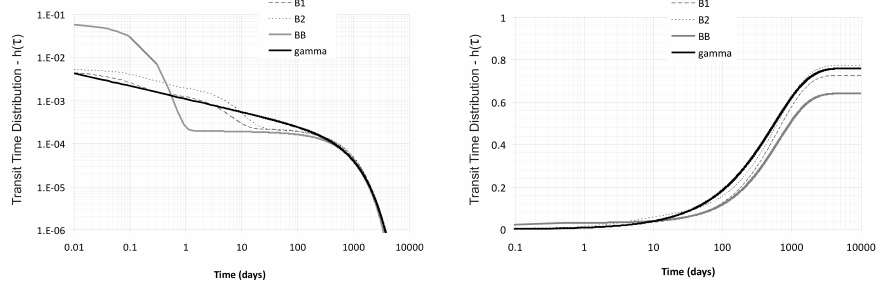
Fig. 7. Transit Time Distribution – TTD for the three catchments for event 2 as shown in Fig. 3 but including a fitted gamma distribution (black line): probability density function – pdf (left) and cumulative density function – cdf